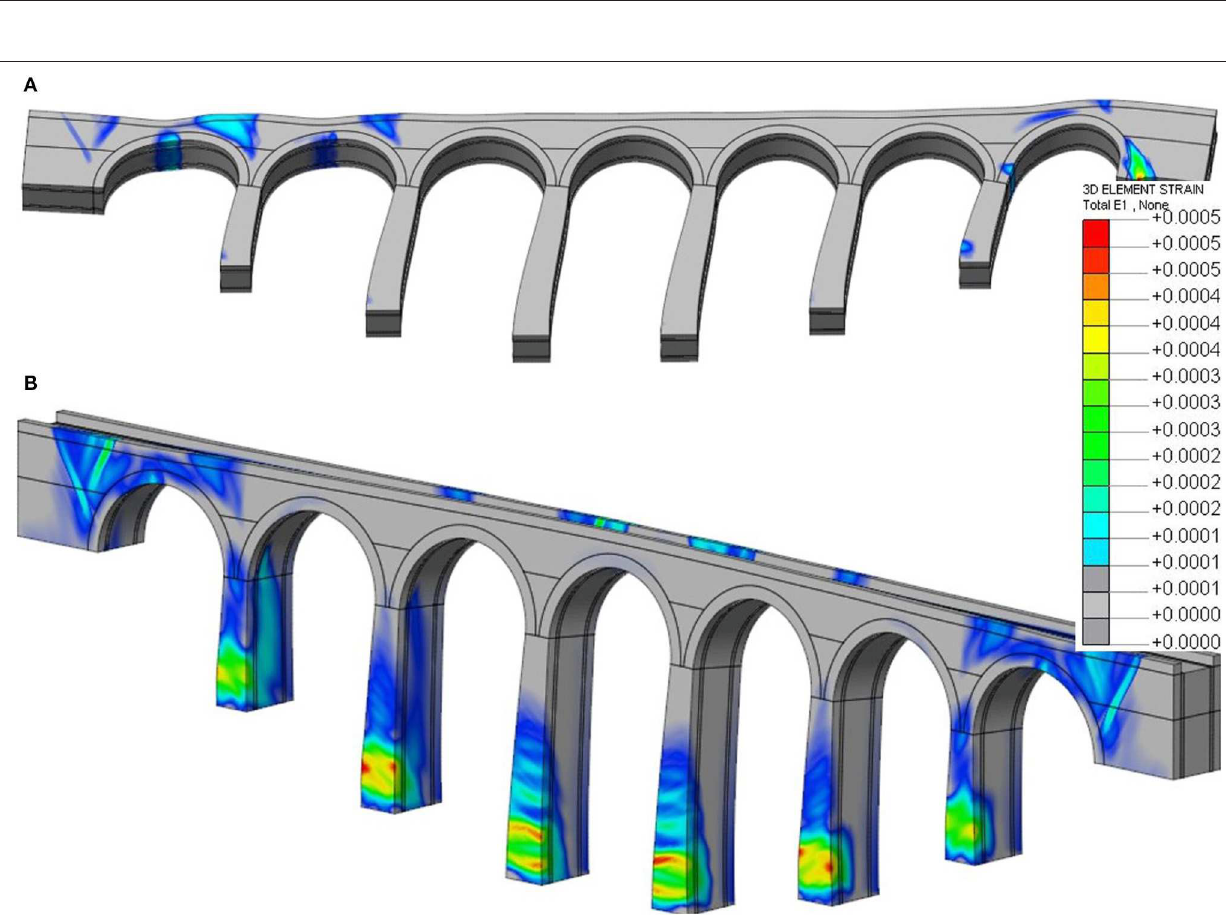
Frontiers in Built Environment |